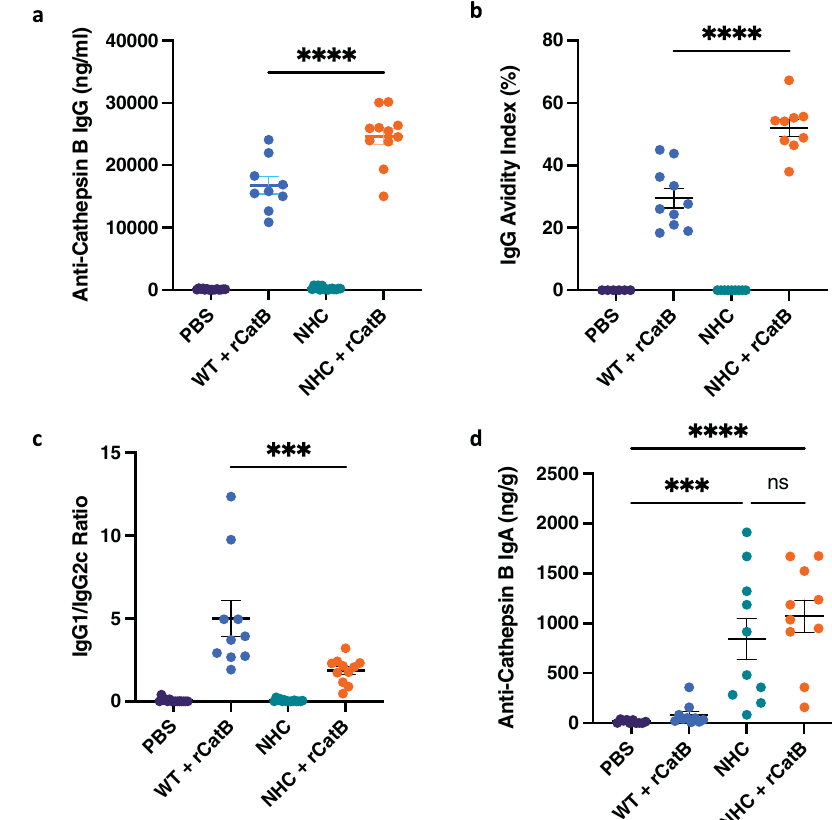
Fig. 2 Humoral responses. Serum and intestinal samples were collected 3 weeks post-vaccination. Anti-Cathepsin B IgG titers expressed as ng/mL ( a ). Anti-CatB IgG avidity index (%) ( b ). The ratio of antigen-speci fi c IgG1 vs IgG2c titers ( c ). Anti-CatB intestinal IgA titers expressed as ng/g ( d ). Each independent experiment consisted of fi ve animals per group. Each experiment was performed twice. Data were shown as mean ± SEM. Statistical signi fi cance was determined by one-way ANOVA with Tukey ’ s multiple comparisons (*** P < 0.001 and **** P <